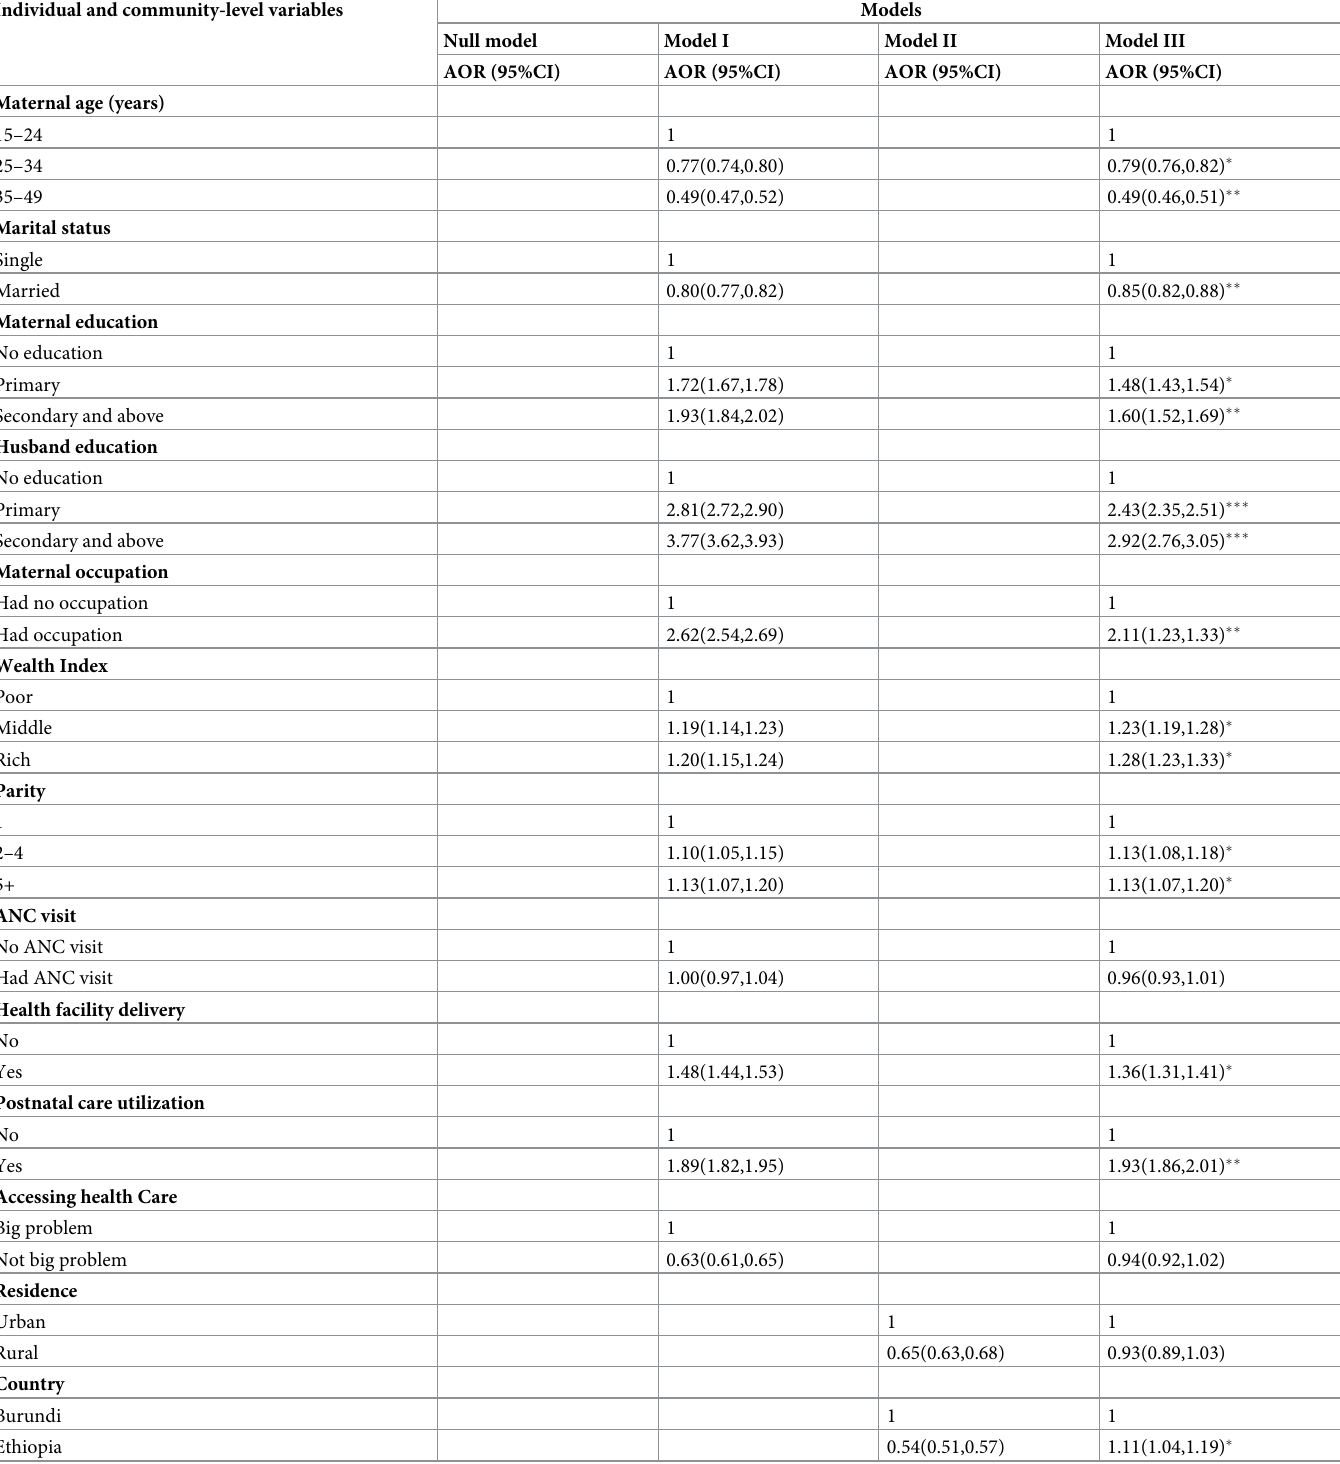
Table 3. Multilevel logistic regression analysis of both individual and community-level factors associated with contraceptive utilization in East Africa countries from 2008 to